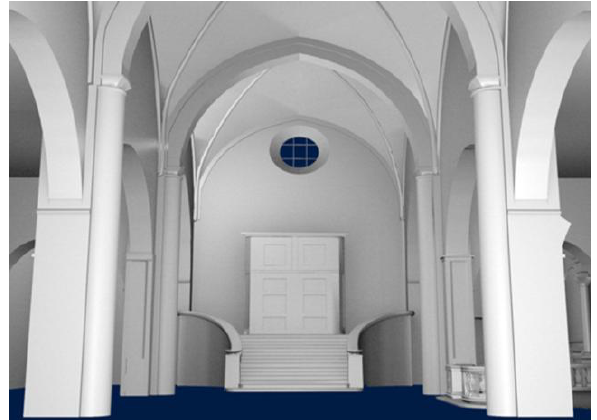
Figure 7. A general view of the achieved 3D model in Blender